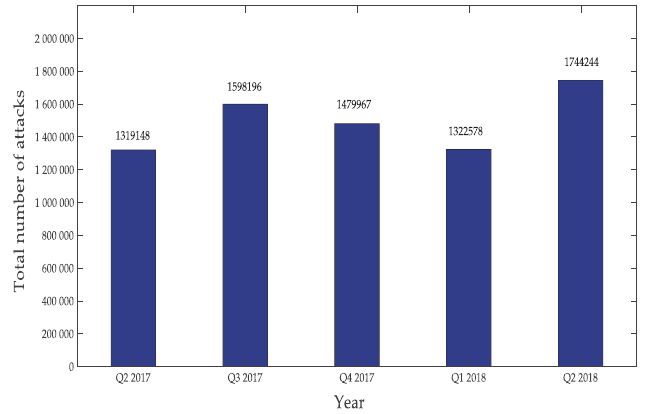
Figure 1. Global mobile threat